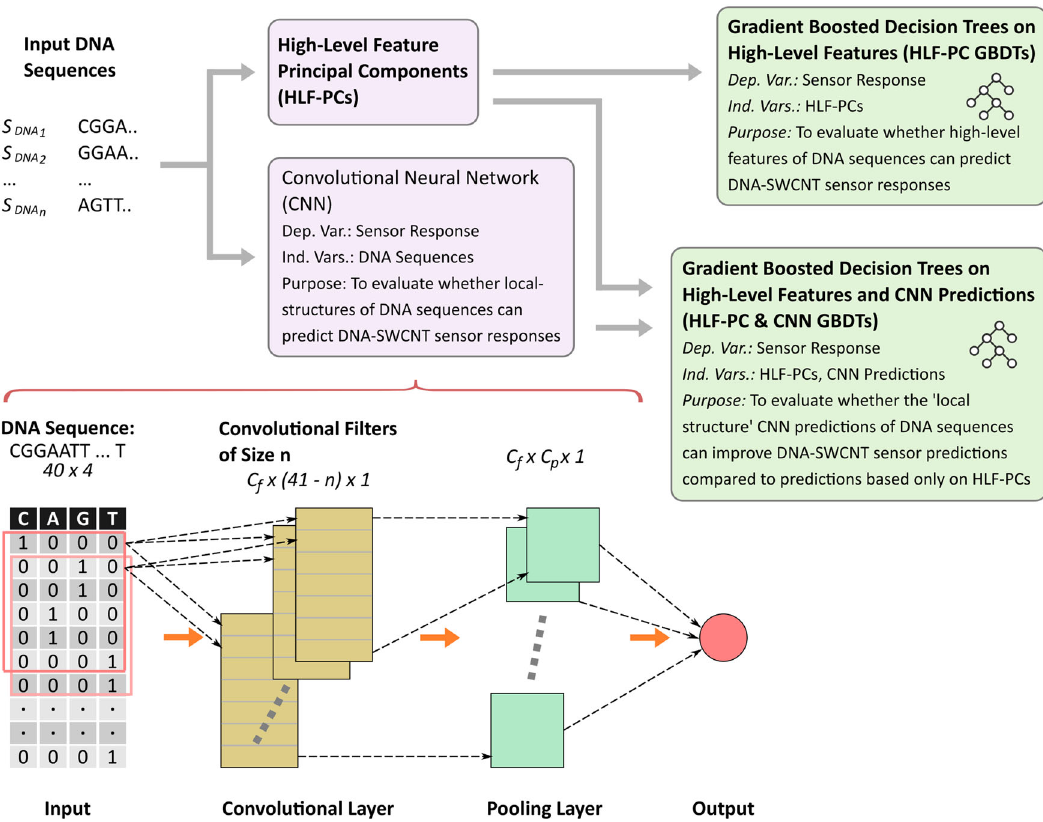
Fig. 2 The top shows an overview of the three Machine Learning (ML) models used for each experimental condition: the convolutional neural network (CNN), the HLF-PC GBDTs, and the HLF-PC & CNN GBDTs. The fi gure includes details regarding the dependent and independent variables used, and the purpose of each model in the analysis. The bottom shows the CNN architecture. First, DNA sequences were vectorized to create the model input using one-hot-encoding (OHE). Then the model input is run through a series of convolutional fi lters and pooling fi lters, where the number of such fi lters is a hyperparameter selected out-of-sample. The intuition behind the use of the CNN is to identify DNA motifs (small sub-sequences of DNA within the strand) that are involved in analyte responses by forming a 'local' structure for analyte